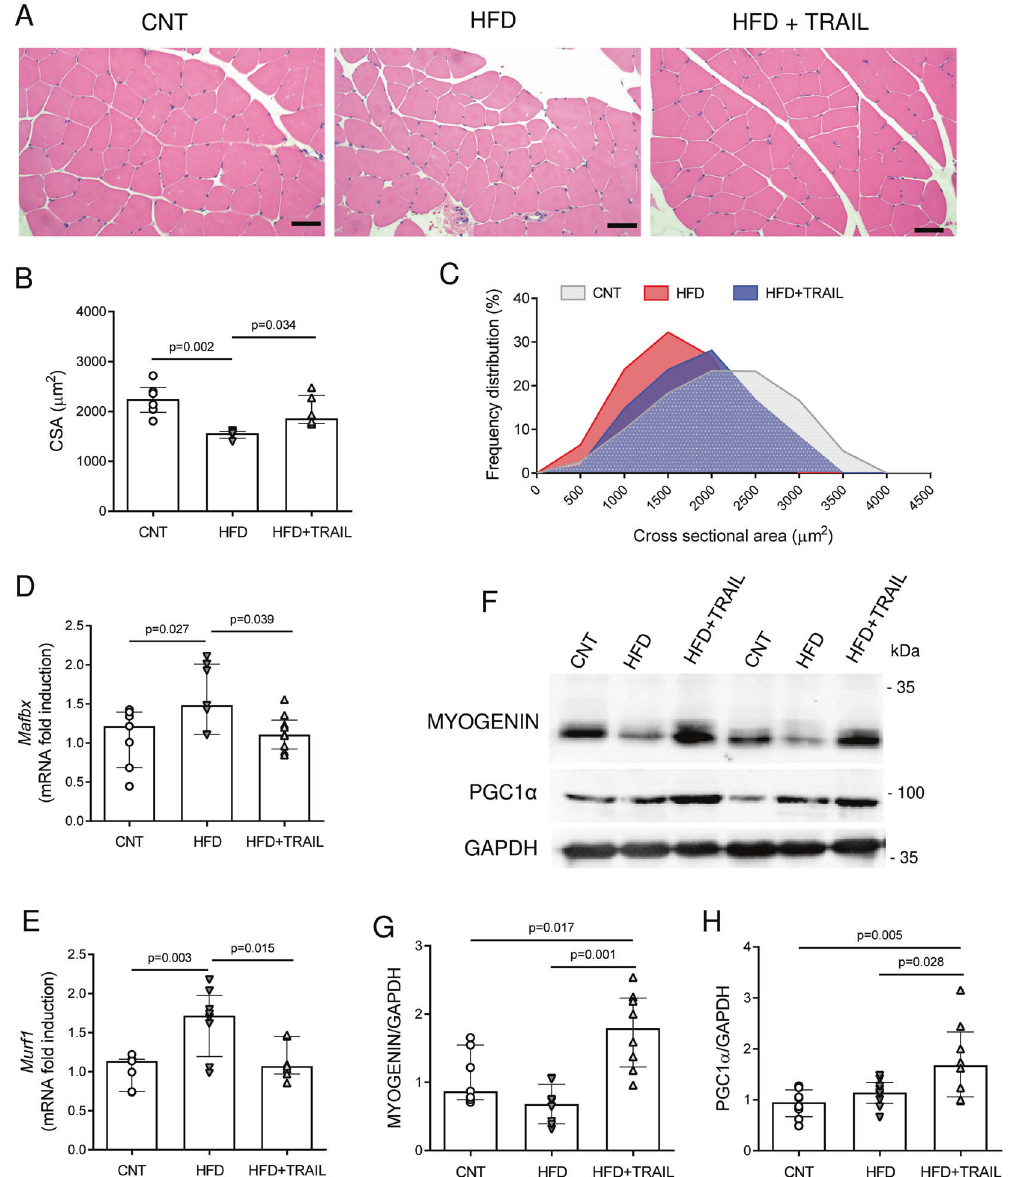
Fig. 5 TRAIL treatment modulates myo fi ber size and function in HFD-fed mice. A Representative images and B – C quanti fi cation of quadricep myo fi ber cross-sectional area (CSA). Scale bar = 50 μ m D – E Skeletal muscle gene expression of Mafbx and Murf1 . Gene expression is reported as mRNA fold induction normalized to CNT. F Representative blots and G – H quanti fi cation of myogenin and PGC1 α protein expression. CNT is for standard diet fed mice, HFD is for HFD-fed mice, and HFD + TRAIL is for HFD-fed mice treated with TRAIL. Results are presented as median with interquartile range. Signi fi cance was assessed with ANOVA and Tukey tests. n = 5 – 9 mice per